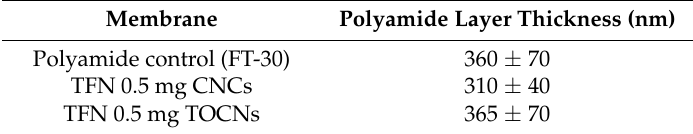
Table 1. Polyamide skin layer thickness determined from TEM imaging of samples.